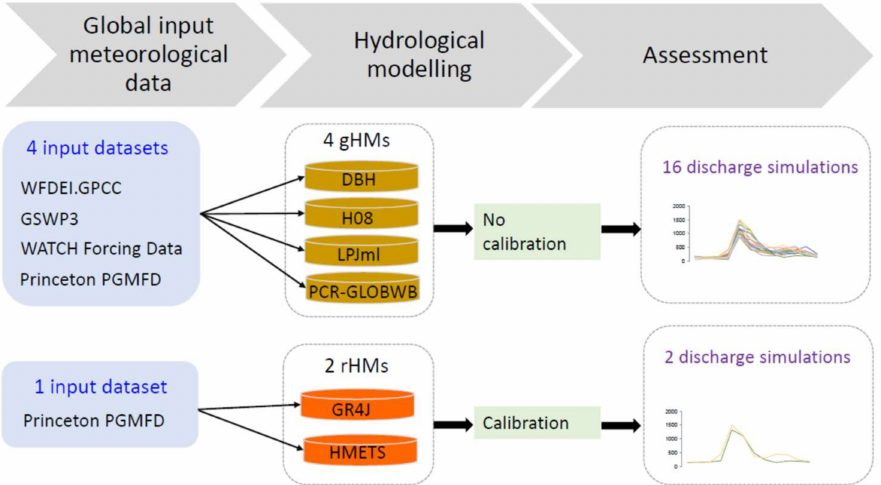
Figure 1. Schematic description of the multi-model approach used in this